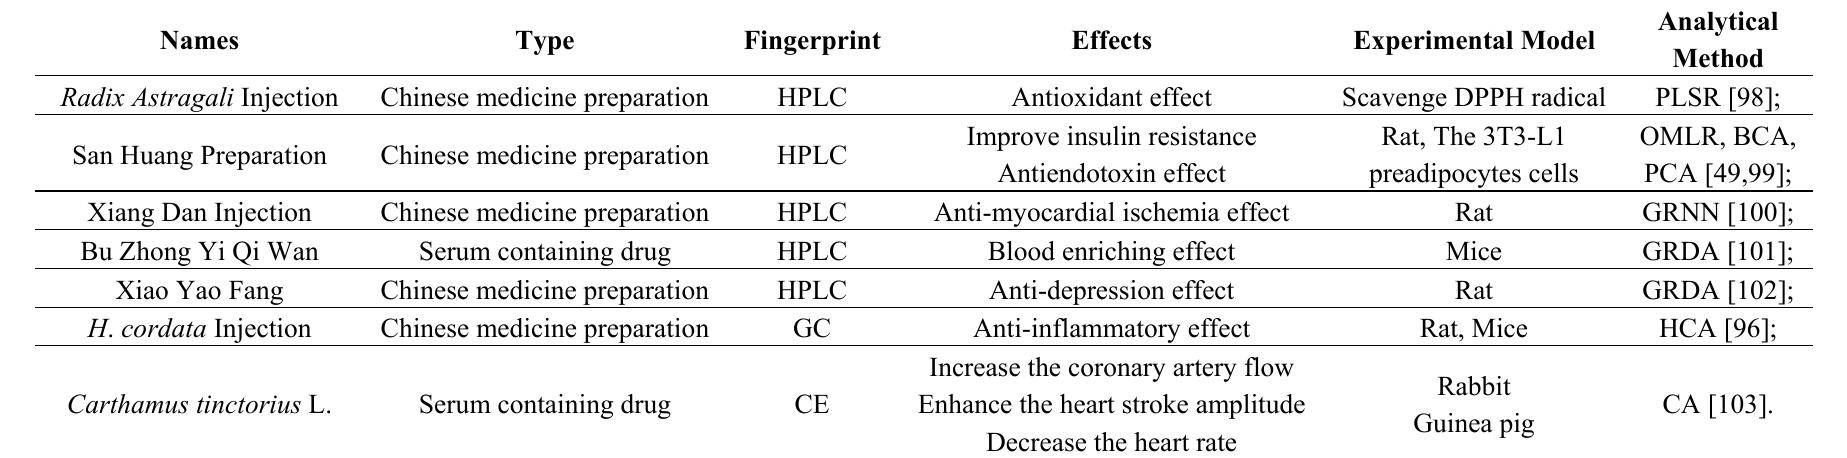
For the meaning of abbreviations refer to the footnotes in Table